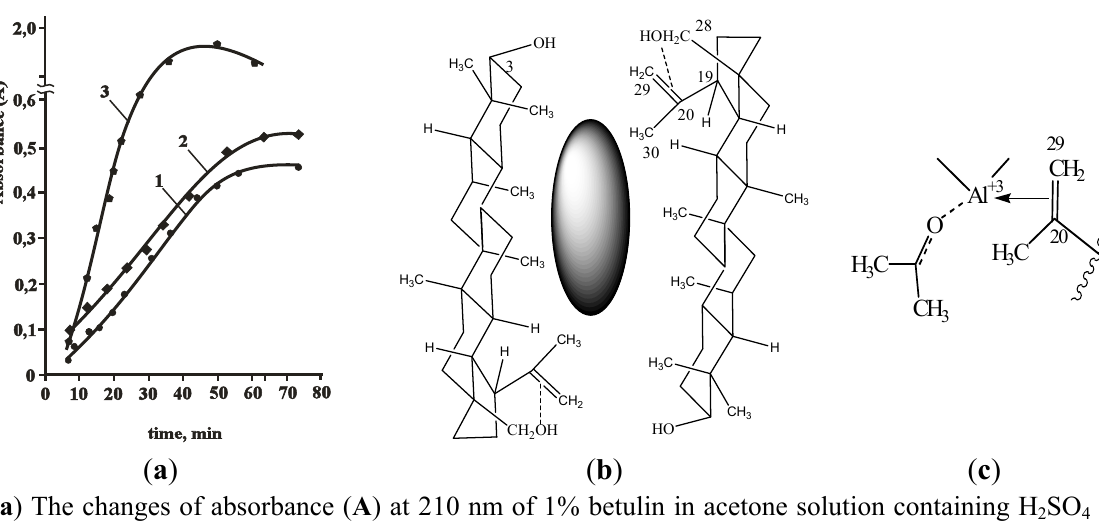
SO and Al (SO ) (curve 2) and Al 2 4 2 4 3